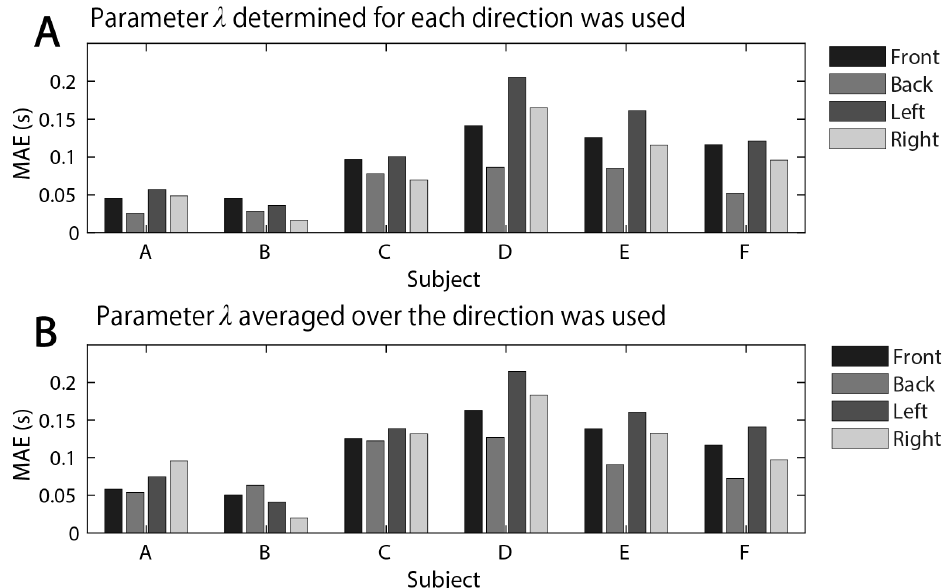
Figure 5. The MAE (mean absolute error) between the average values of the measured and model movement duration over the subjects. ( A ) When the λ determined for each direction was used. ( B ) When the average value of λ over four directions was